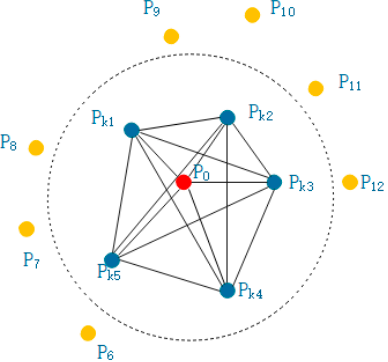
Figure 2. Schematic diagram of Point Feature Histogram neighborhood.